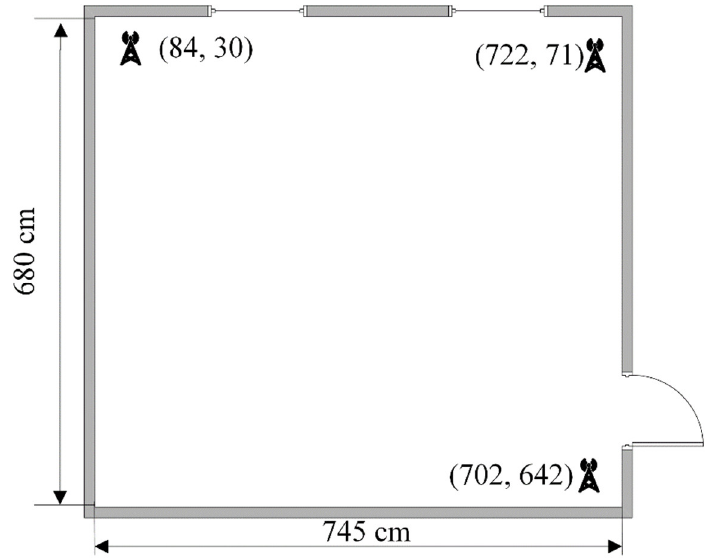
Figure 4. Plan of the premise for testing of the IPS.